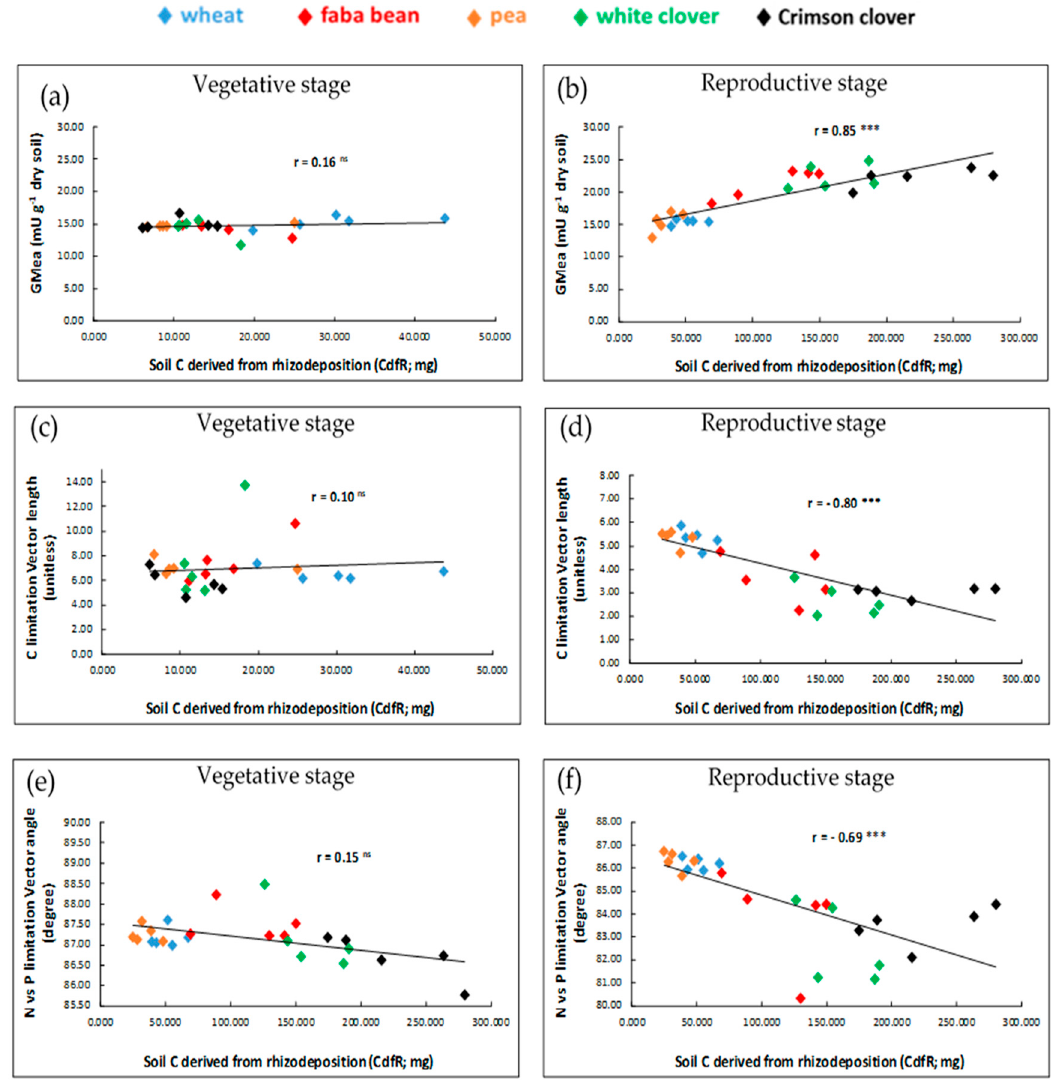
Figure 7. Pearson correlation of soil C derived from rhizodeposition with ( a , b ) GMea of enzymes activities. BG: β -glucosidase; NAG: N-acetyl-glucosaminidase; ACP: acid phosphatase; ( c , d ) vector length; ( e , f ) vector angle at vegetative and reproductive stage. Significant correlations ( p < 0.05; n = 25) are shown by * p ≤ 0.05, ** p ≤ 0.01 and *** p ≤ 0.001.